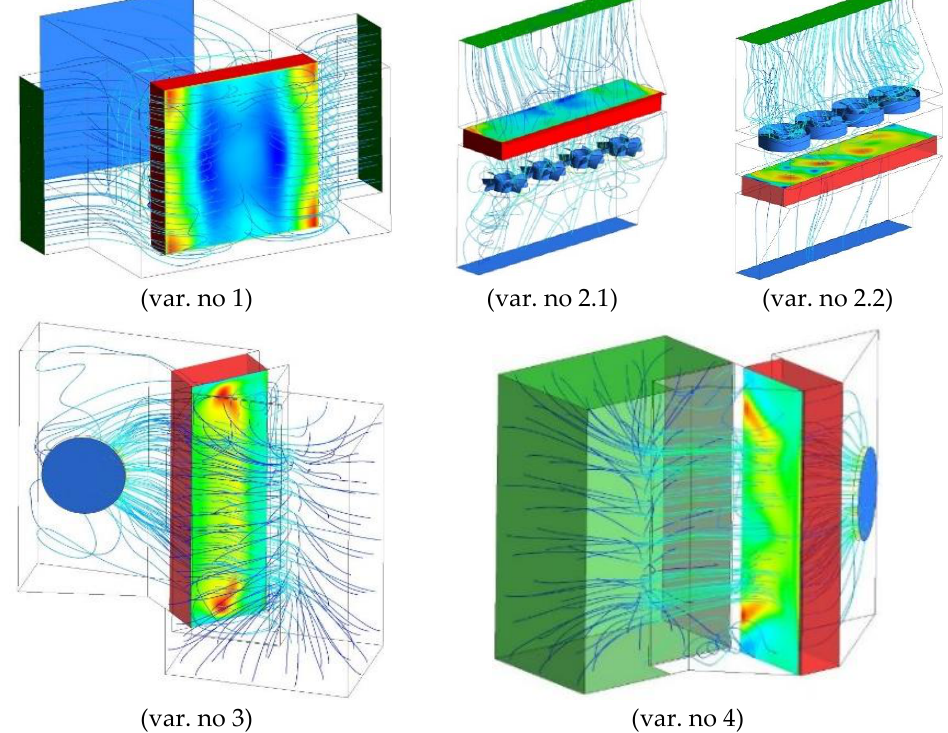
Figure 11. CFD results with streamlines and velocity profiles on the incident surface of the evaporator for the simulated geometrical variants. Variant 1 (4 axial, square), Variant 2.1 (4 axial suction side) and Variant 2.2 (4 axial pressure side), Variant 3 (radial), Variant 4 (radial).